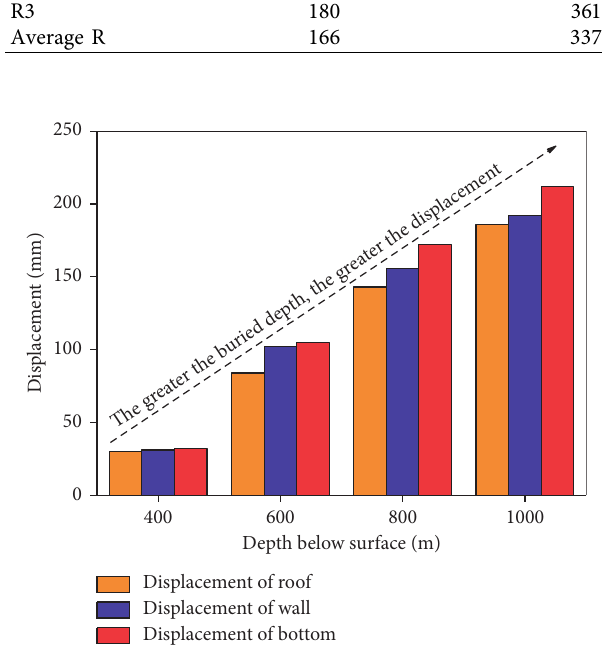
Figure 10: Relationship between buried depth and displacement of roadway surrounding